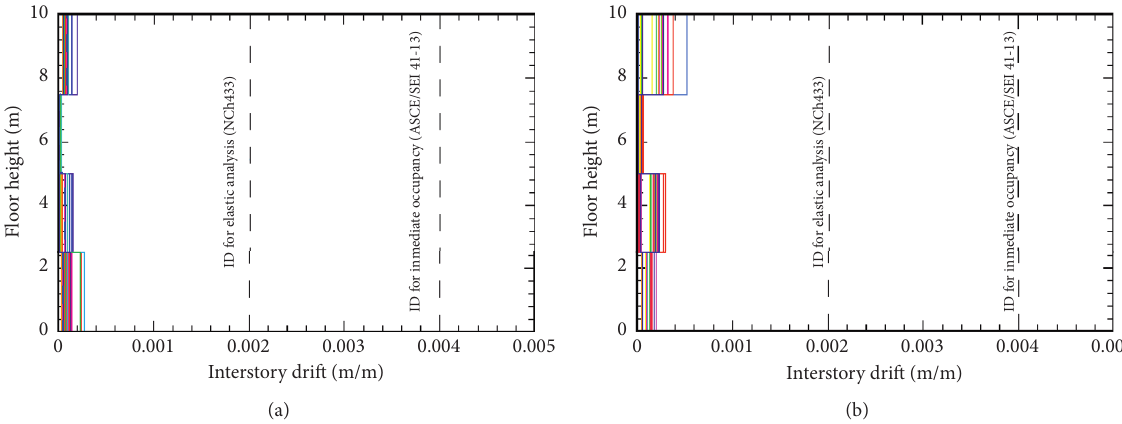
Figure 6: Interstory drift results for the 4-story model as per the Chilean code shaking level for (a) the long-duration set and (b) the short- duration